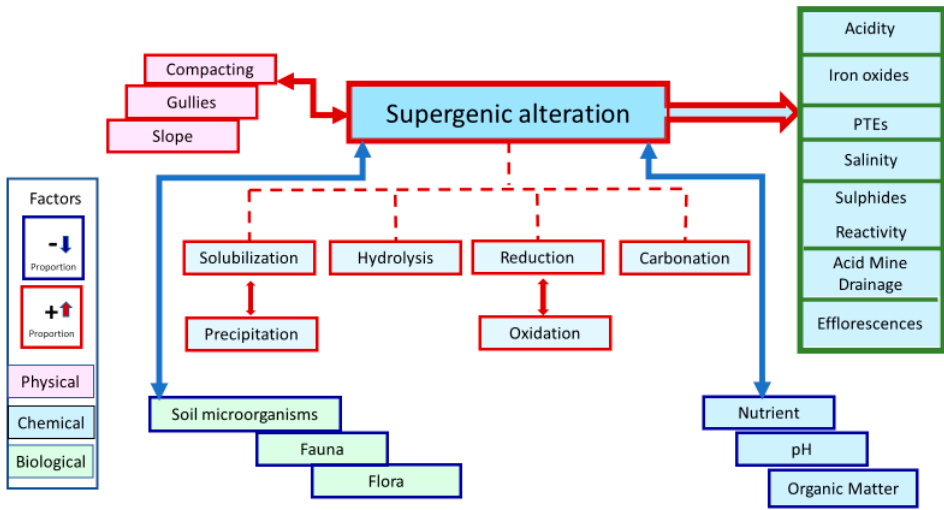
Figure 5. Processes involved in the mining tailings